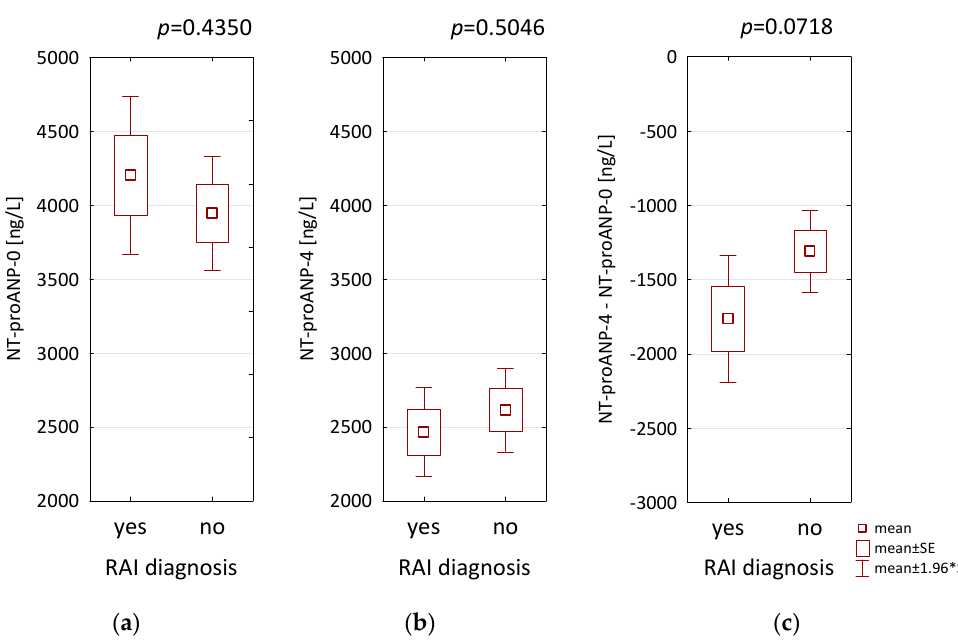
Figure 2. The comparison of NT-proANP concentrations on admission (NT-proANP-0) ( a ), on the 4th day of hospitalization (NT-proANP-4) ( b ) and the difference between two assays ( c ) depending on the diagnosis of right atrial infarction (RAI).